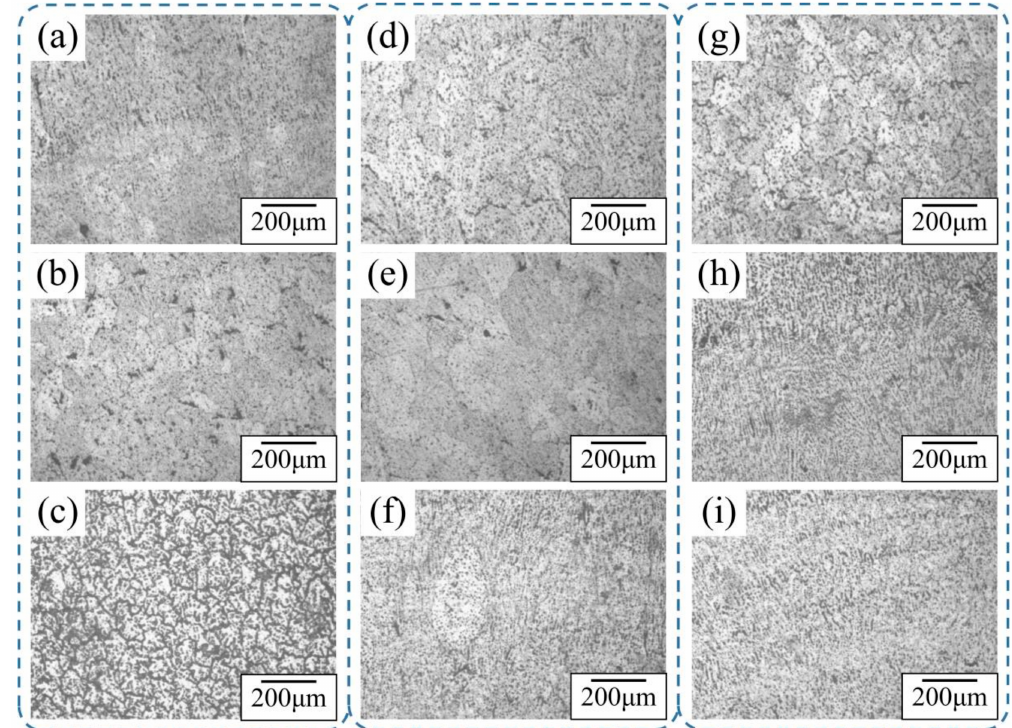
Figure 8. Microstructure of specimens from different processes. ( a ) Structure of top section of Specimen A. ( b ) Structure of middle section of Specimen A. ( c ) Structure of bottom section of Specimen A. ( d ) Structure of top section of Specimen B. ( e ) Structure of middle section of Specimen B. ( f ) Structure of bottom section of Specimen B. ( g ) Structure of top section of Specimen D. ( h ) Structure of middle section of Specimen D. ( i ) Structure of bottom section of Specimen